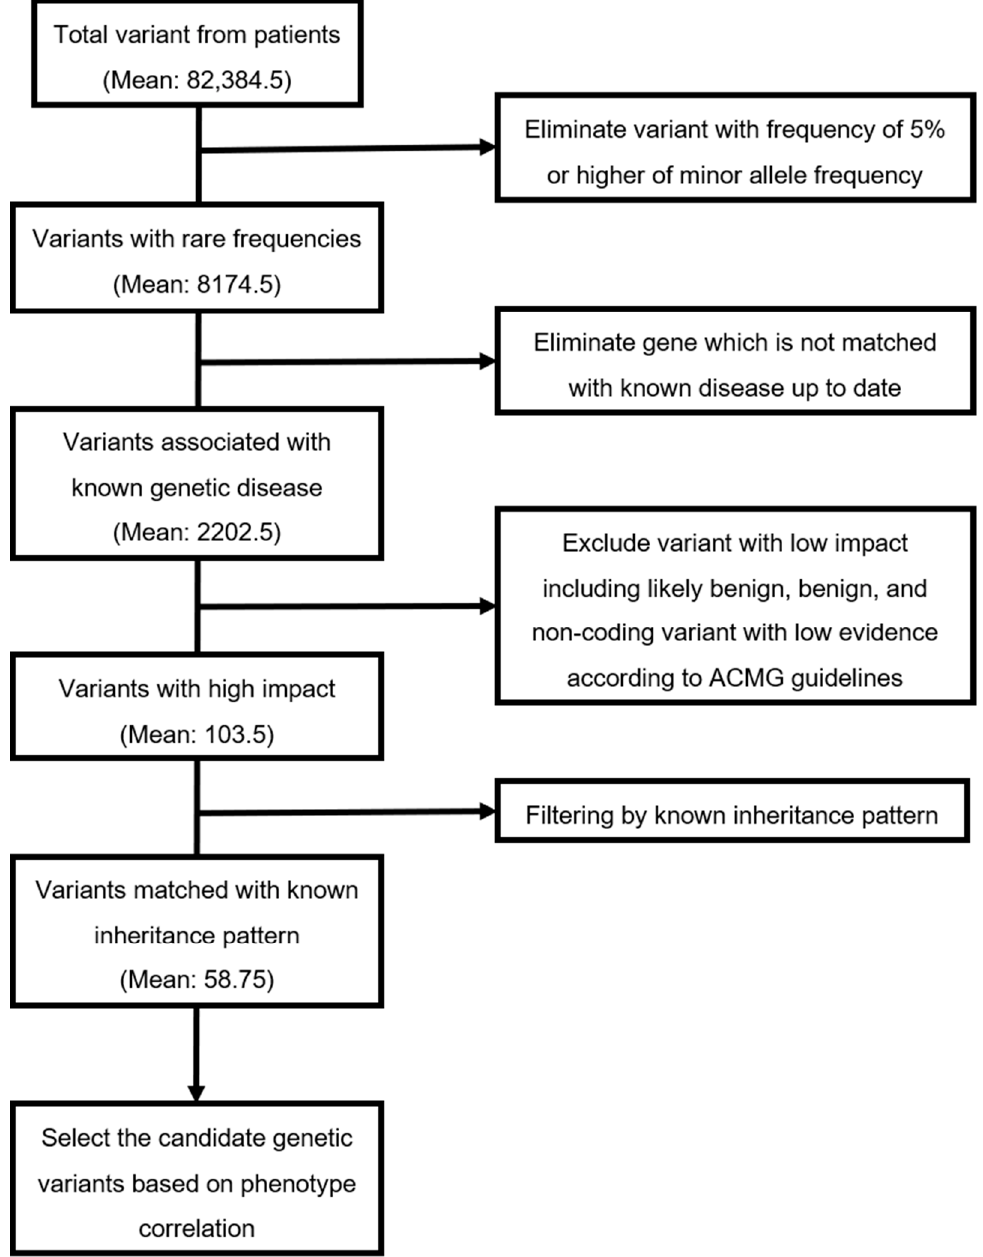
Figure 1. The filtering process to identify the candidate variants.